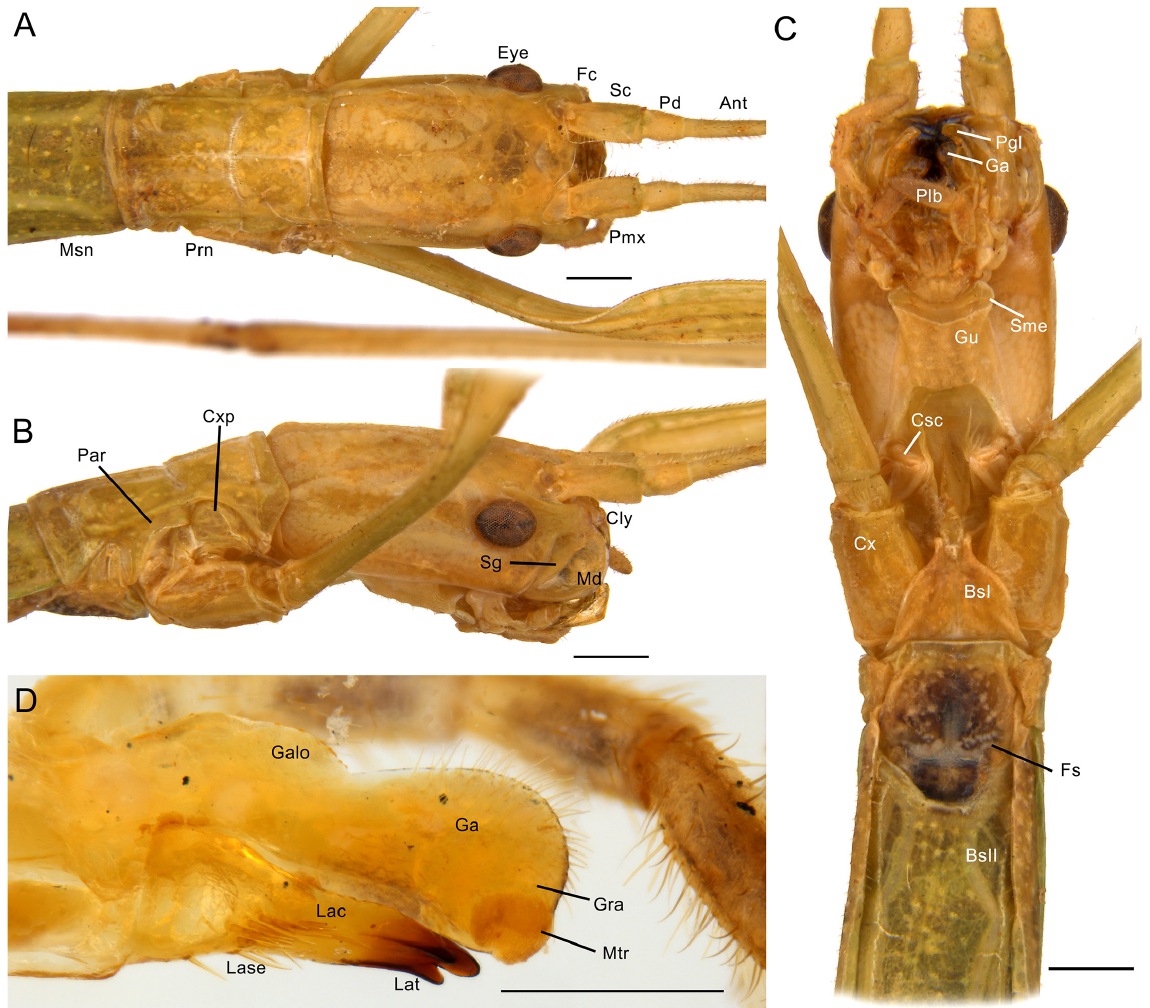
Fig. 15. Arumatia anyami Ghirotto, Crispino & Neves gen. et sp. nov., head and prothorax morphology. A–C . Holotype, ♀ (MZUSP 1091). D . Paratype (MZUSP 1320). A . Head and prothorax in dorsal view. B . Head and prothorax in lateral view. C . Head and prothorax in ventral view. D . Right maxilla, dorsal (internal) view. Abbreviations: Ant = antennomere; BsI-II = pro- and mesothoracic basisterna; Cly = clypeus; Csc = cervical sclerite; Cx = coxa; Cxp = coxopleurite; Eye = compound eye; Fc = frontal convexity; Fs = prothoracic furcasternite; Ga = galea; Galo = galealobulus; Gra = granules; Gu = gula; Lac = lacinia; Lase = lacinial setae; Lat = lacinial teeth; Md = mandible; Msn = mesonotum; Mtr = microtrichia; Par = paranota; Pd = pedicellus; Pgl = paraglossa; Plb = labial palpus; Pmx = maxillary palpus; Prn = pronotum; Sc = scapus; Sg = subgena; Sme = submentum. Scale bars: A–C = 1 mm; D = 0.5